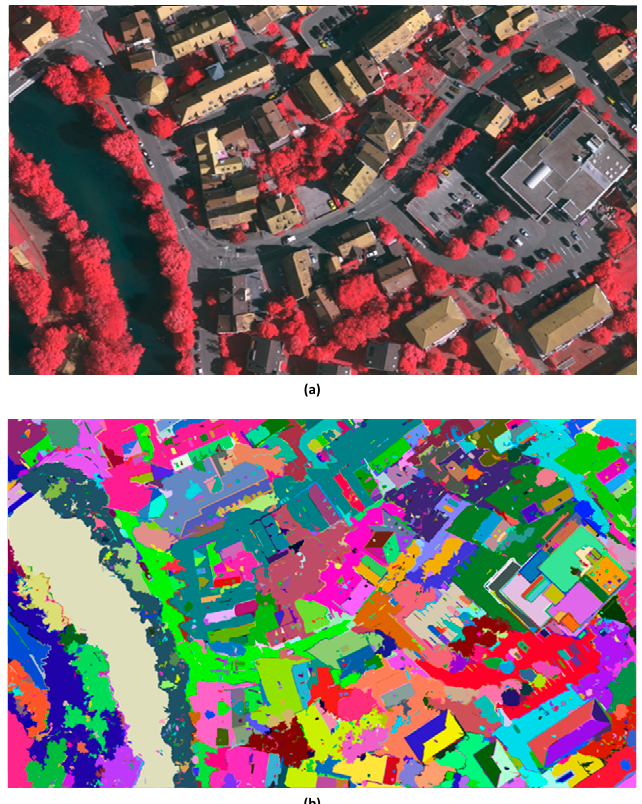
Figure 3. ( a ) The original image; ( b ) The segmented image after graph-based segmentation method, where σ = 0.8, k = 500, min = 50.